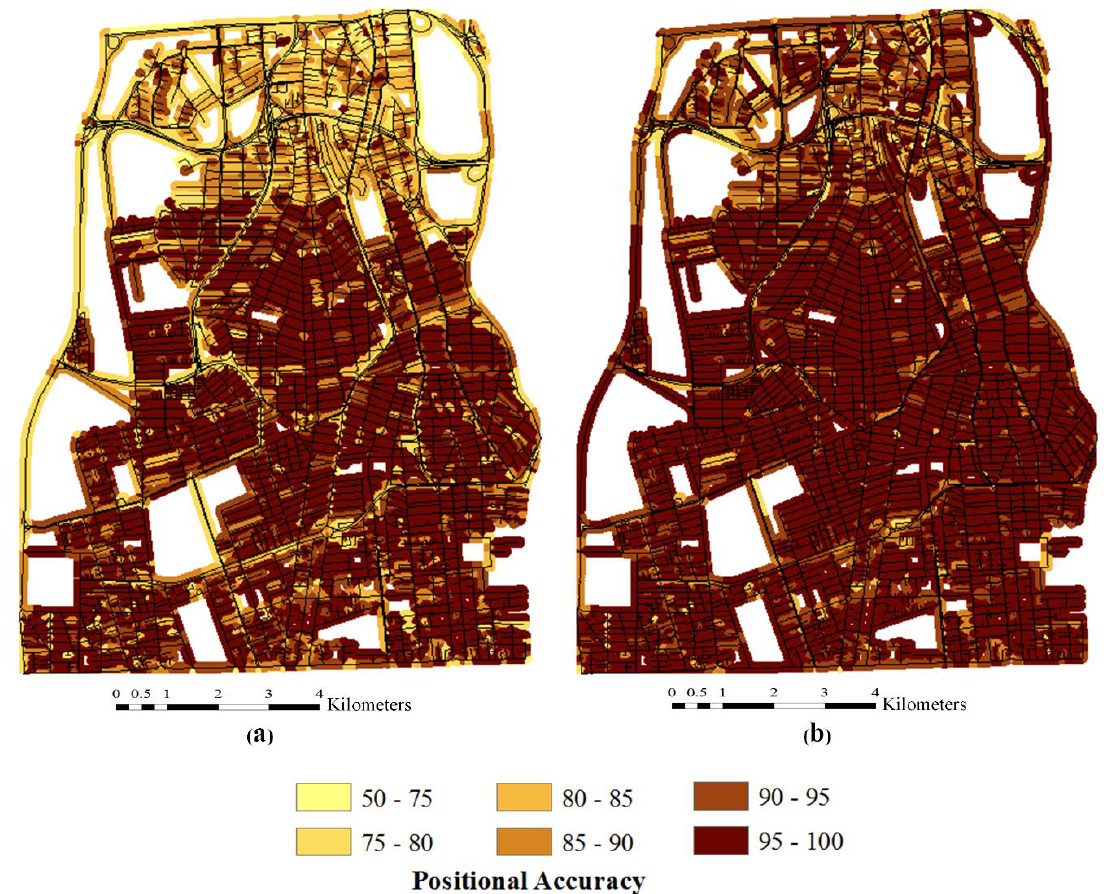
Figure 19. ( a ) The computed positional accuracy of the latest version of OSM dataset; and ( b ) the computed positional accuracy of the enhanced dataset.